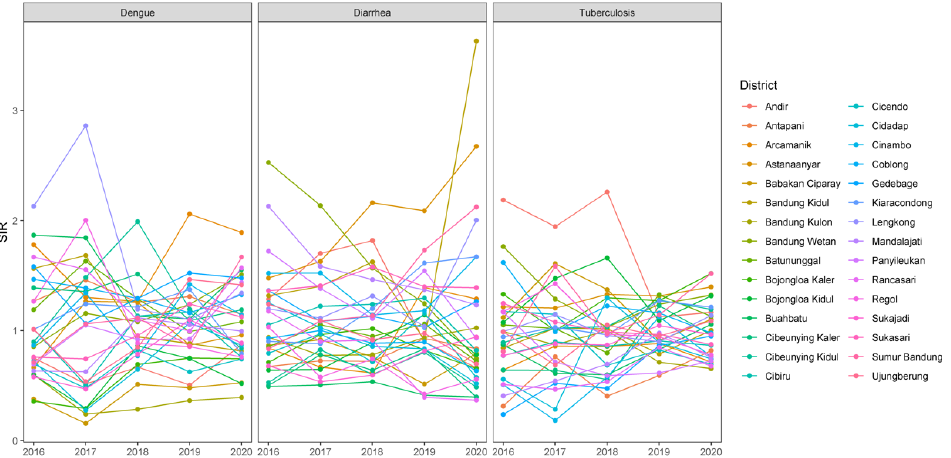
Fig. 3. Temporal trend of the standardized incidence ratio (SIR) for three infectious diseases between